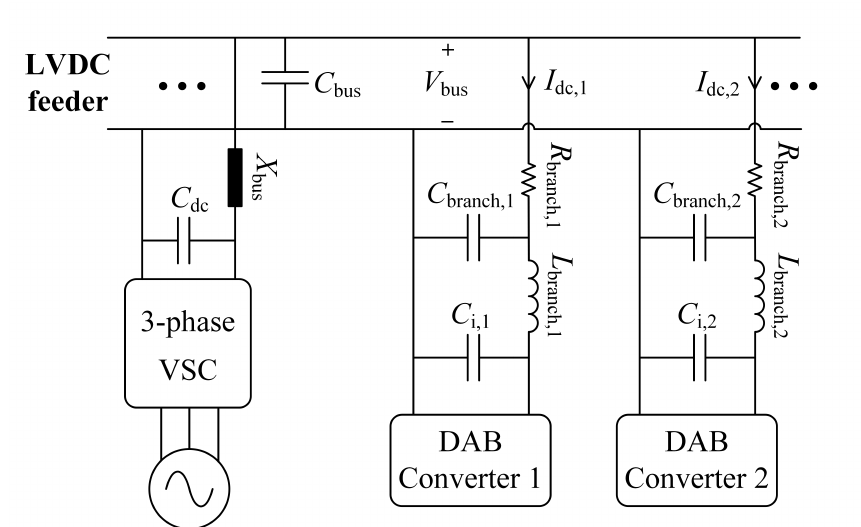
Figure 3. An example network of charging stations at the LVDC